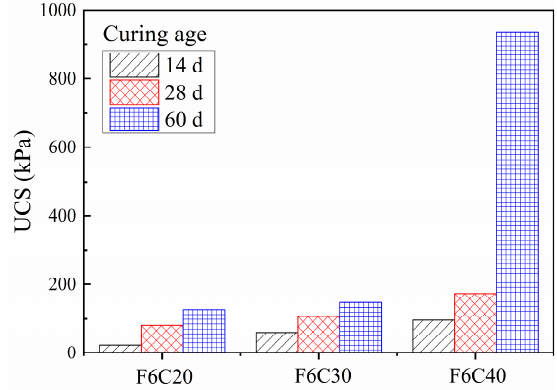
Figure 6. Effect of cement content on the strength of CDS with 6% FA.